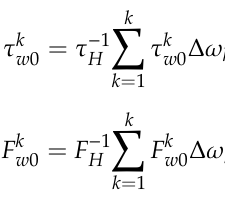
τ (Equation (28)) normalized by the external Ω Ω = . Only edge values 1 and p p Ω are indicated in a caption to Figure 5. On p